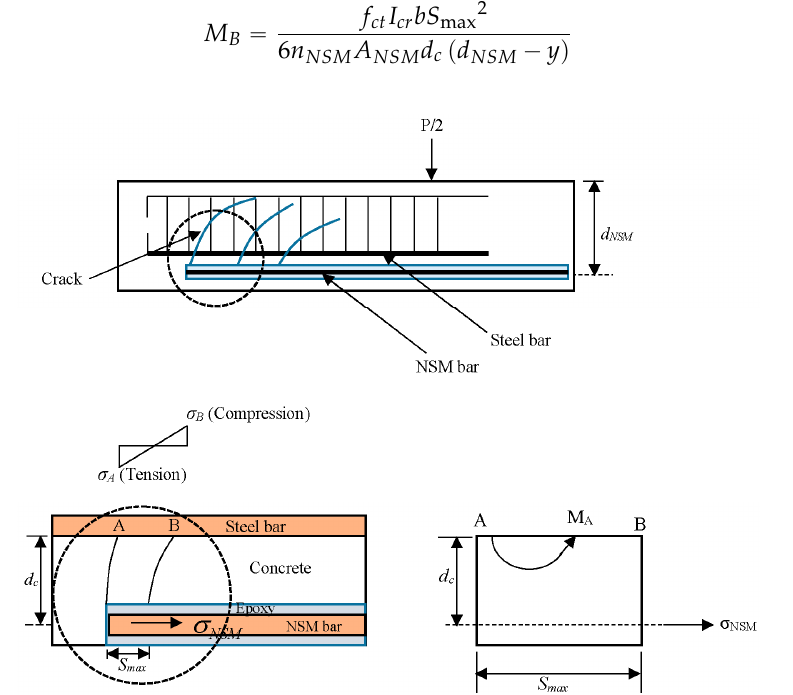
Figure 13. Distribution of stress in the NSM bars and concrete between the last two adjacent cracks at the end of the NSM bars.